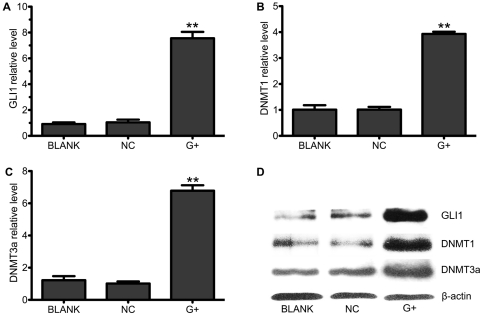
DNMT1 and DNMT3a were up-regulated after GLI1 over-expression.BxPC-3 cells were transfected with pGC-FU-GLI1, relative expression of GLI1, DNMT1 and DNMT3a mRNA was assessed by qRT-PCR (A, B, C), while the expression of GLI1, DNMT1 and DNMT3a protein was analyzed by Western blot (D). The inset showed a substantial increase in DNMT1 and DNMT3a expression after GLI1 over-expression. The results were normalized to that of β-actin expression. All data were presented as the mean ± SD of three independent experiments.